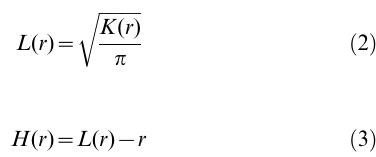
Figure S1 Experimental determination of the localiza- tion accuracy of mEosFP by a coordinate-based algo- rithm. The nearest neighbor distribution of a single-molecule data set of Gag.mEosFP (n= 7,522 single-molecule localizations) was calculated. The maximum, representing localization accuracy, was found at 28 nm. Figure S2 Experimental determination of the localiza- tion accuracy of Alexa Fluor 647 by a coordinate-based algorithm. The nearest neighbor distribution of a single- molecule data set of Alexa Fluor 647 (n= 4,196 single-molecule localizations) was calculated. The maximum, representing fluor- ophore localization accuracy, was found at 15 nm. (TIF) Figure S3 Increased sensitivity of Gag assembly site detection. HeLa cells were transfected with pCHIV mEosFP , fixed 24 hpt, stained by indirect immunofluorescence using MAb b12 and goat anti-human Alexa Fluor 647, and imaged by super- resolution TIRF microscopy as described in Materials and Methods. A representative region from the plasma membrane, showing the superposition of a PALM image for Gag.mEosFP (green) and the corresponding dSTORM image of Env stained with Alexa Fluor 647 (red), respectively. Scale bars represent 1 m m.